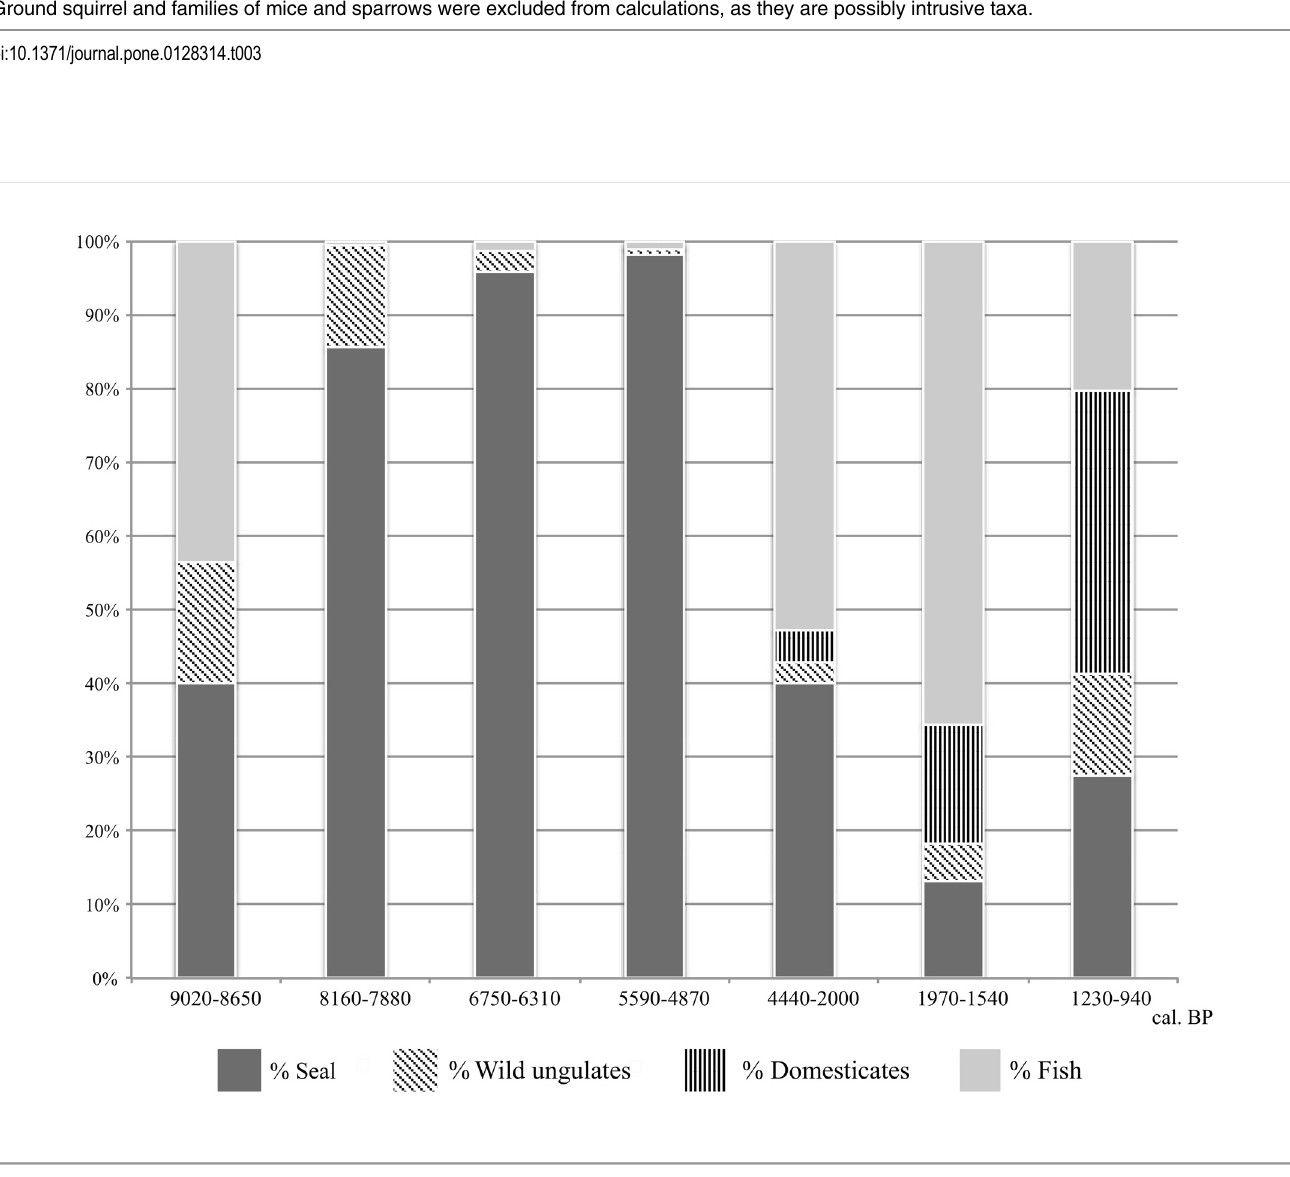
Fig 4. Plot of the relative abundances of seals, wild ungulates, domesticated ungulates, and fish at Sagan-Zaba II by analytical unit. NISP values for each group were used to calculate the percentages